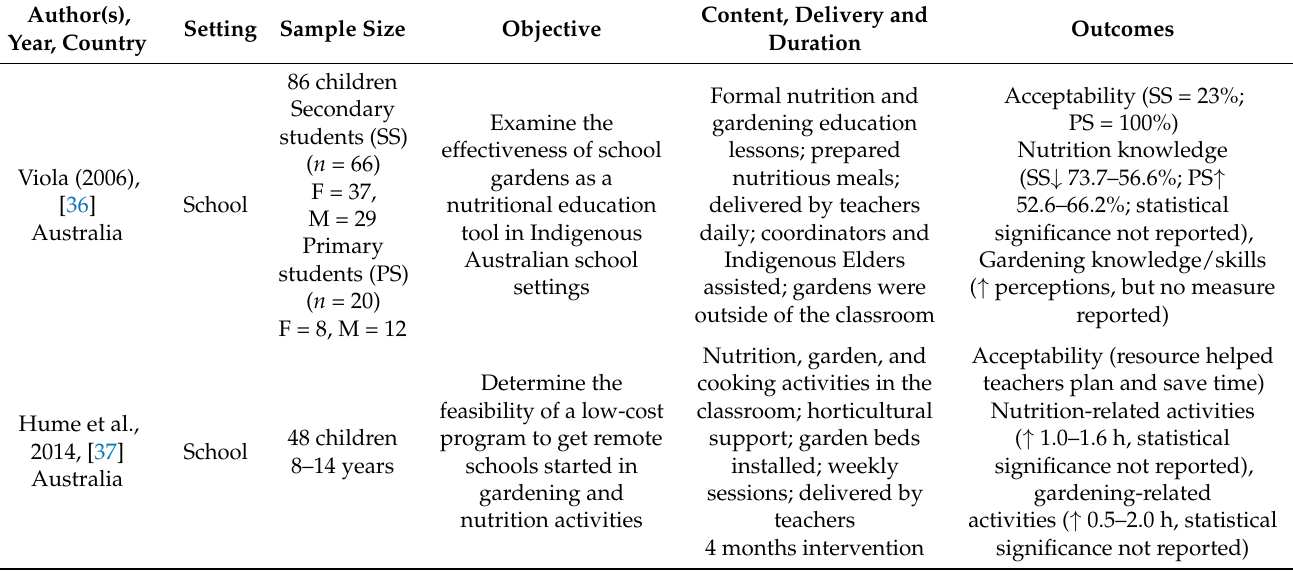
Table 1. Summary Characteristics of Scoped Studies.